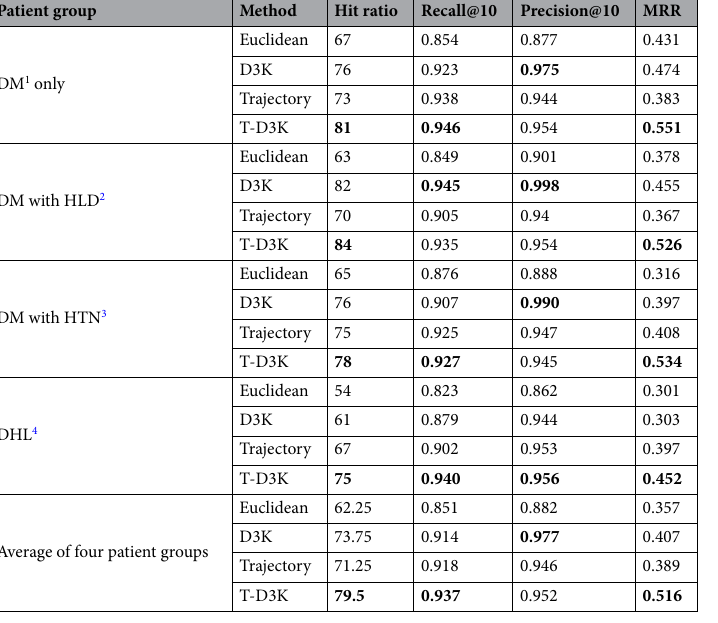
Table 2. Comparison of the Hit ratio, Recall@10, Precision@10 and MRR of the various methods for the four groups of patients. 1 DM denotes patients with T2DM only, DM with HLD 2 denotes T2DM patients with hyperlipidaemia (HLD), DM with HTN 3 denotes T2DM patients with hypertension (HTN), and DHL 4 denotes T2DM patients with hyperlipidaemia and hypertension (DHL). 5 Hit ratio % is the proportion patients with recommendations that have an exact match (both the type and dosage) with prescribed medications. 6 Recall measures the number of common medication type and dose between recommended set (S) and ground truth set (G) over ground truth set (G). 7 Precision measures the number of common medication type and dose between recommended set (S) and ground truth (G) over recommended set (S). [Bold] figures represent the best performance among the four similarity approach for each comorbidities